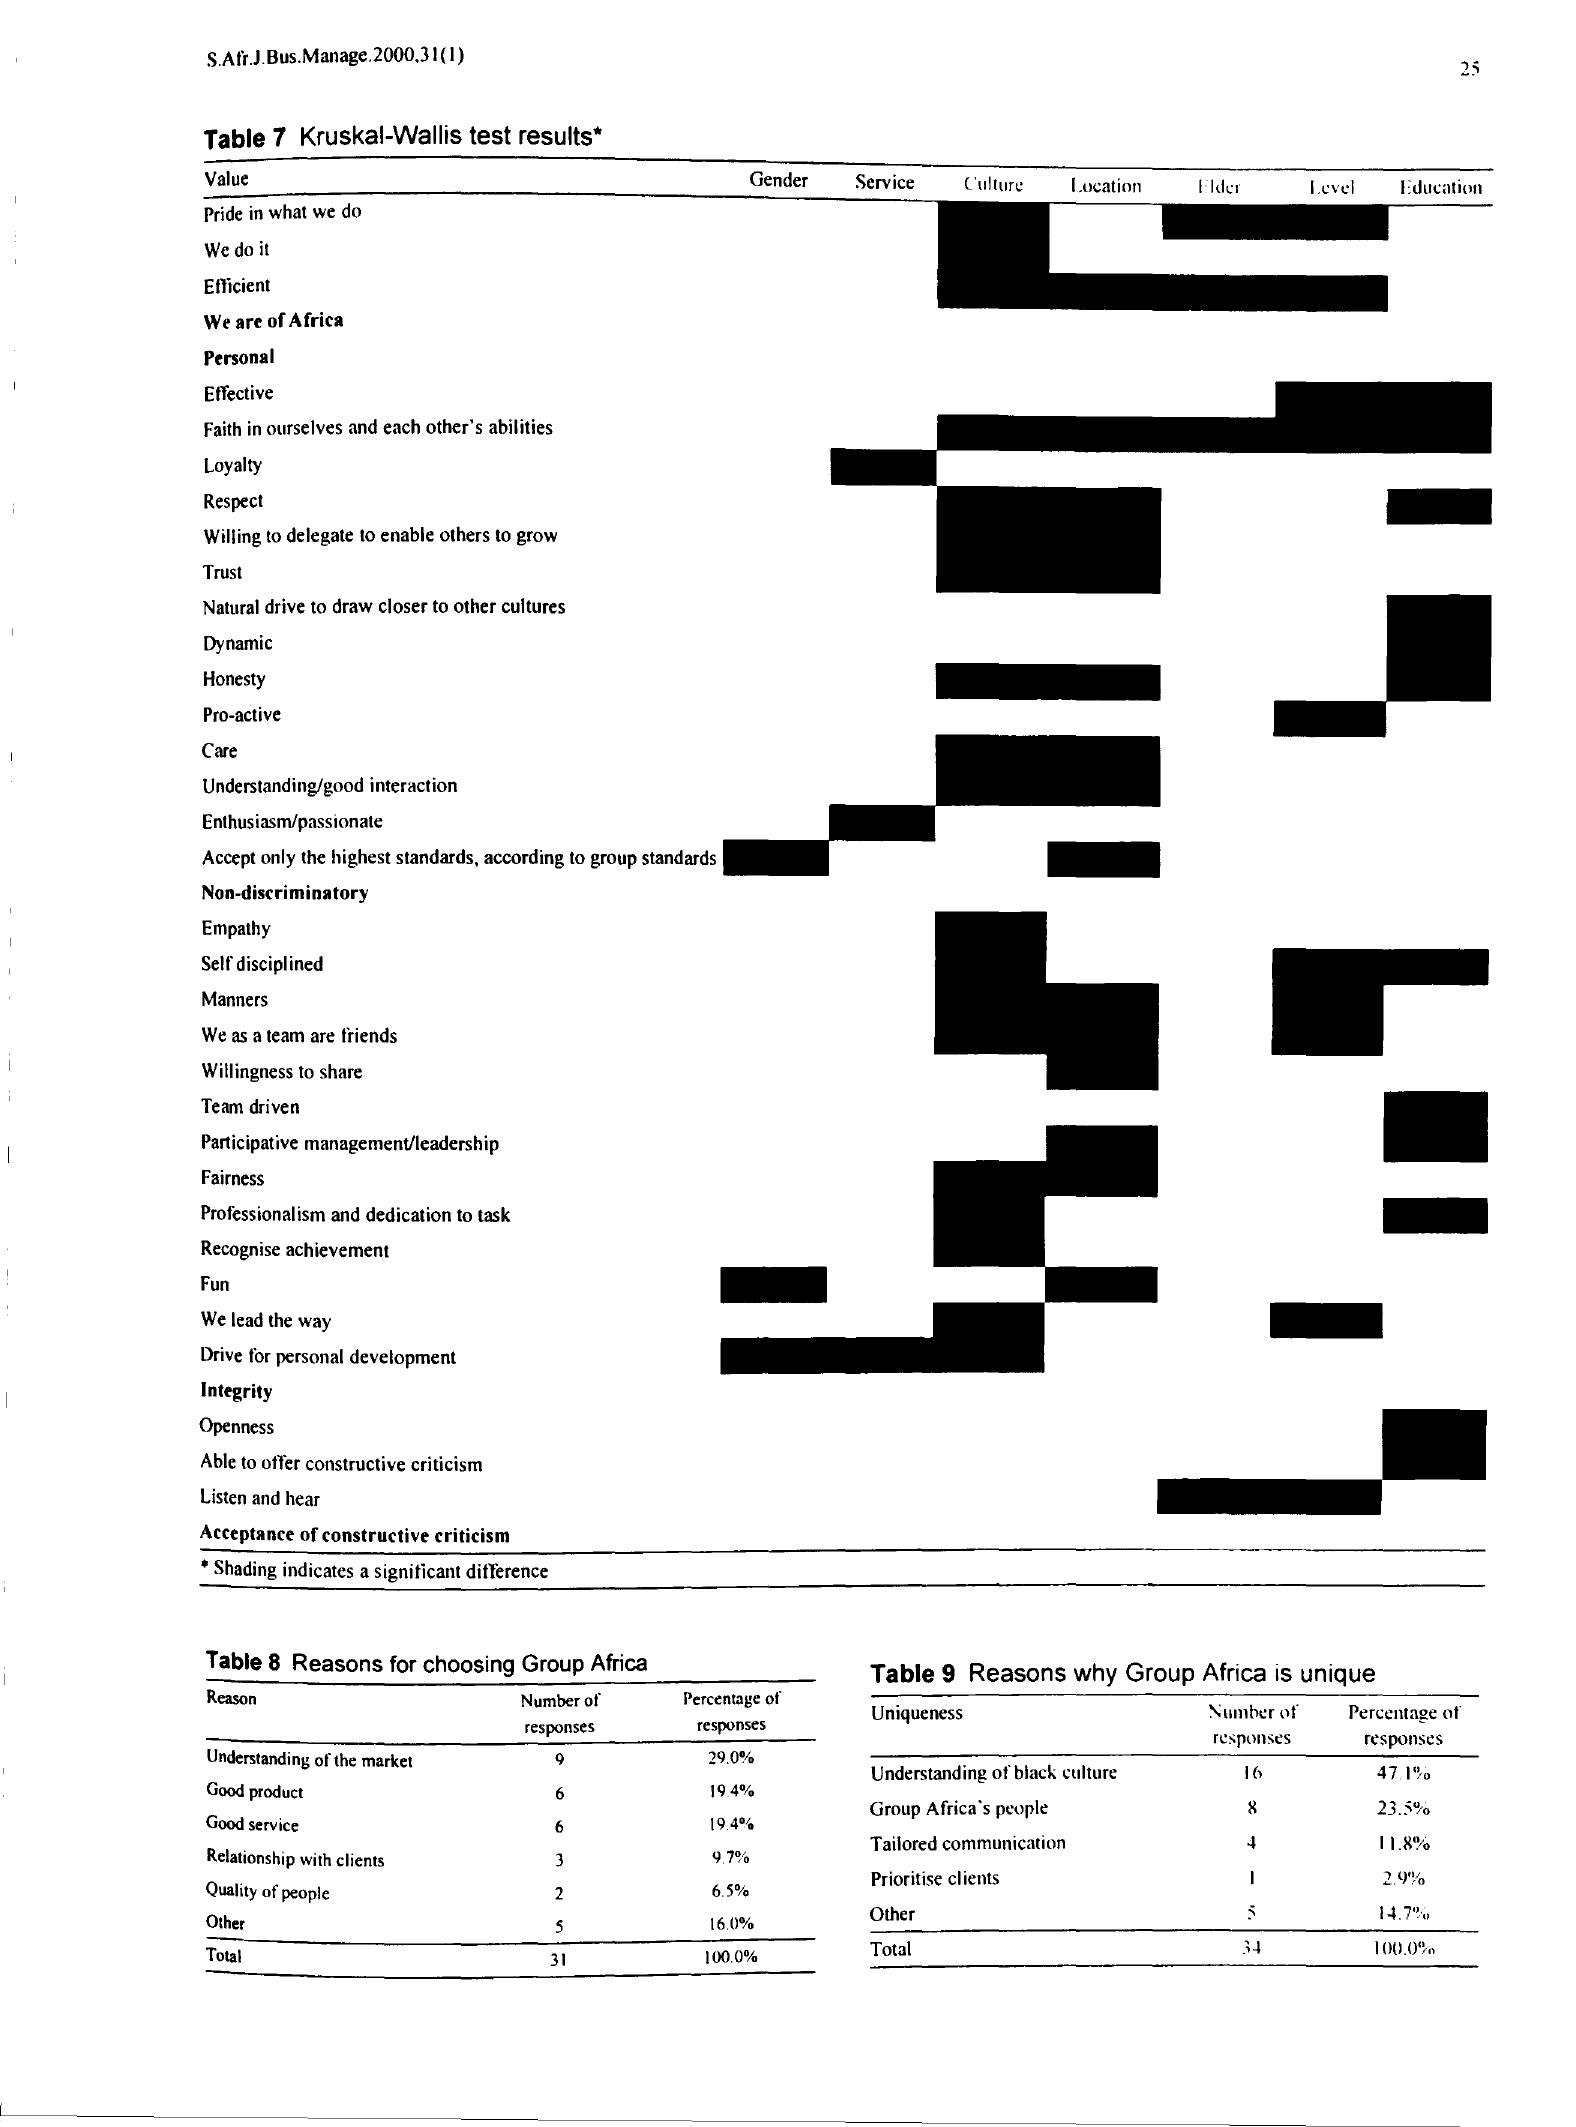
Table 7 Kruskal-Wallis test results*